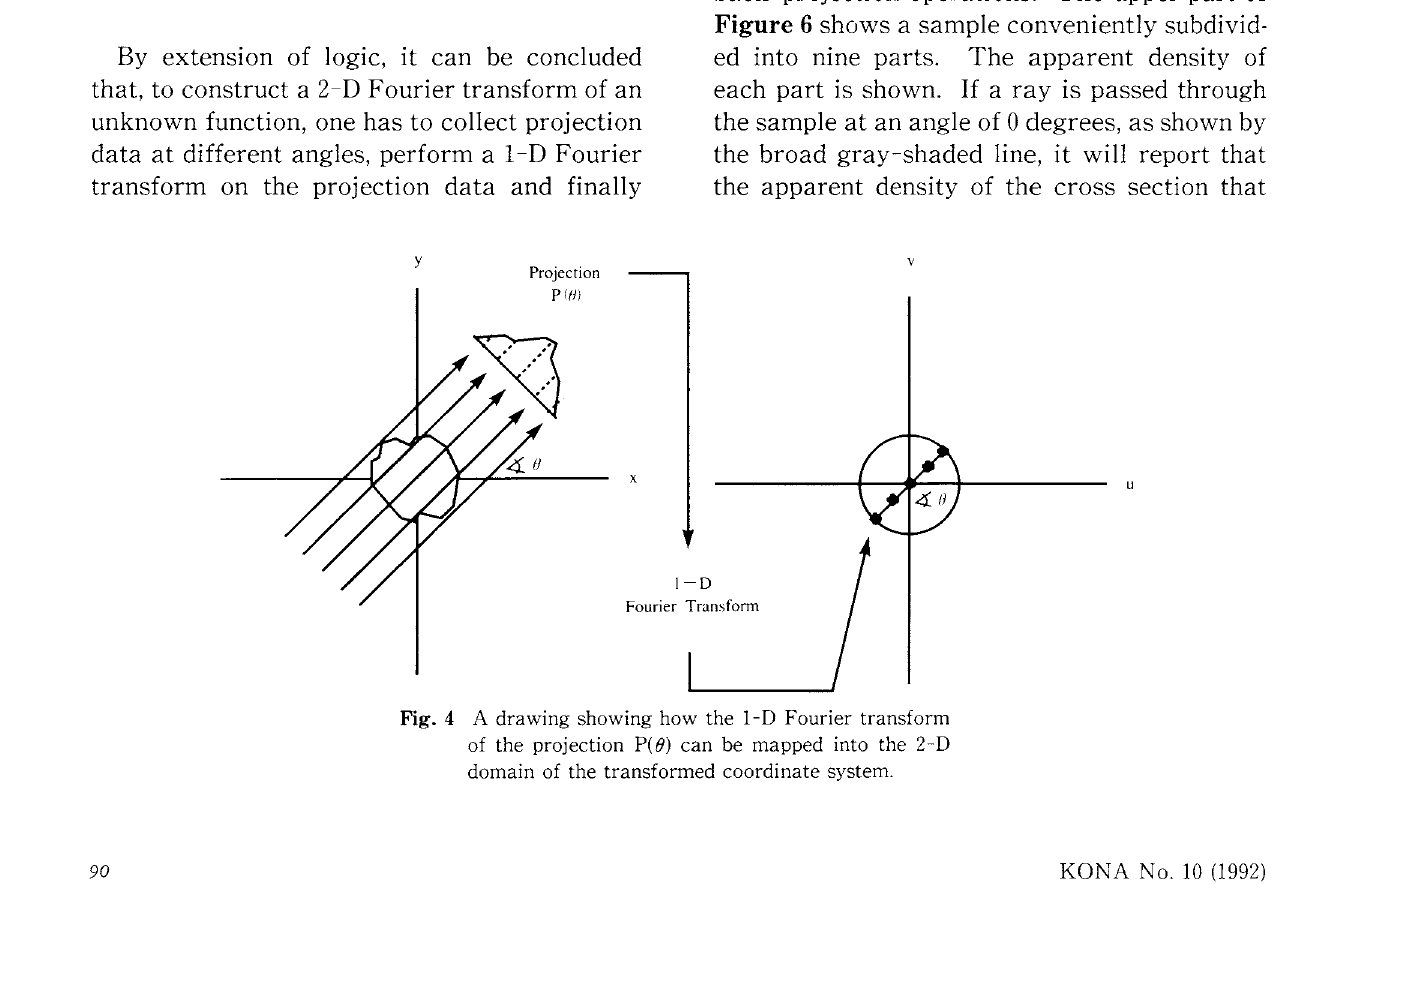
Fig. 3 An illustration showing the function f(x,y) after it undergoes a 2-D Fourier transform operation. The transformed coordinate system is designated by vari ables u and v.